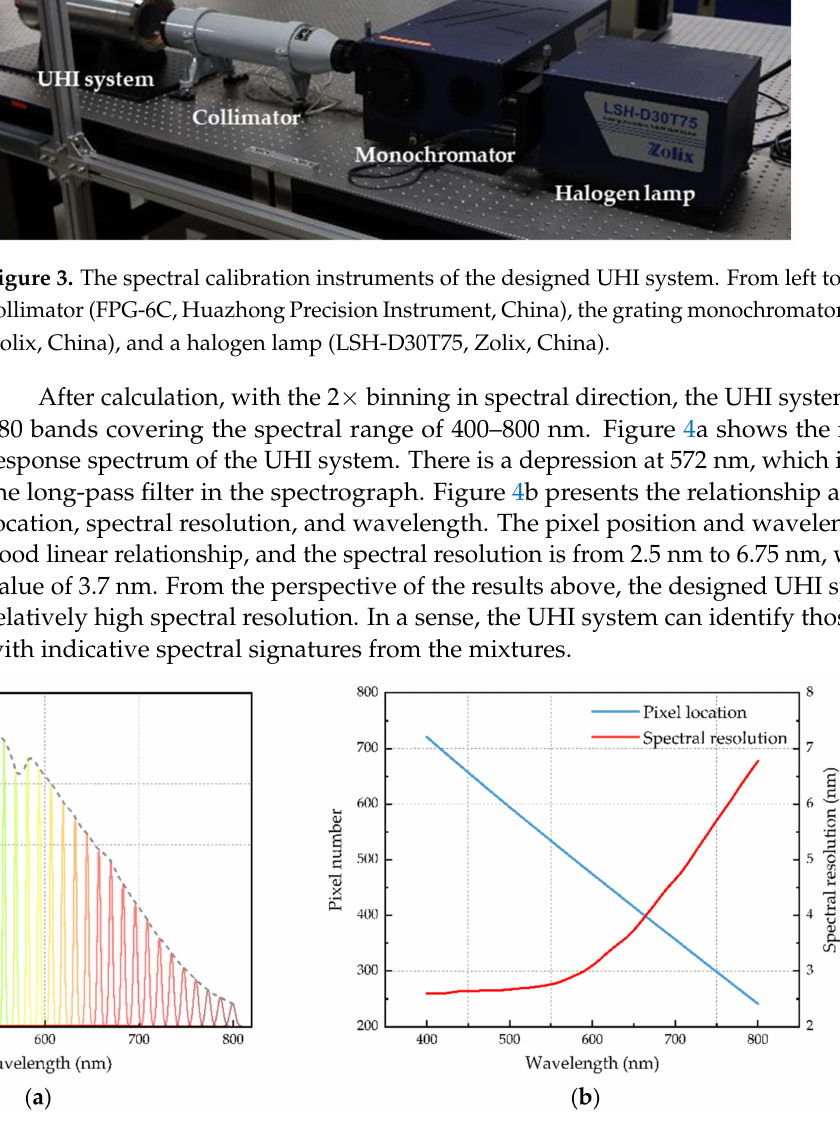
Figure 4. The results of the spectral calibration: ( a ) the normalized response spectrum of the designed UHI system in 400 nm to 800 nm; ( b ) the relationship among pixel location, spectral resolution, and wavelength,